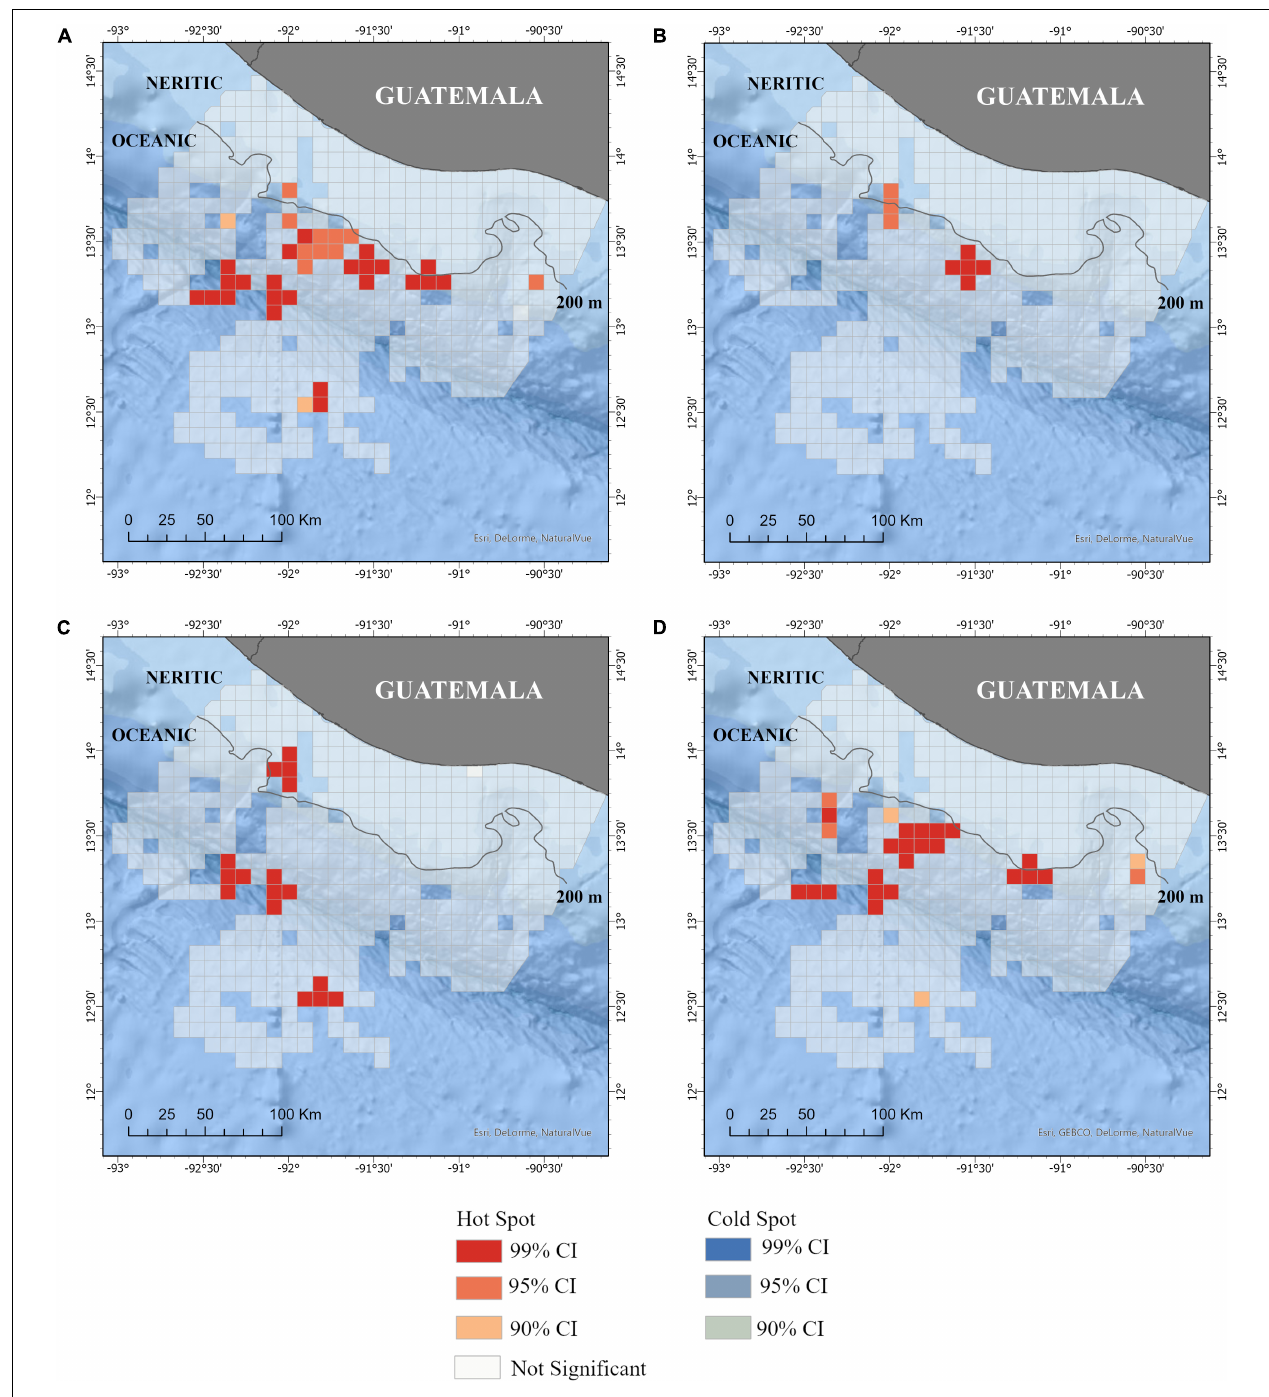
FIGURE 5 | Hot spots of distribution of all cetacean species (A) and the three most common species: (B) Tursiops truncatus , (C) Stenella attenuata , and (D) Stenella longirostris in the Pacific waters of Guatemala. No cold spots were identified. Neritic ( < 200 m depth) and ocean ( > 200 m depth) zones are also included. Additional details of the study area are shown in Figure 1